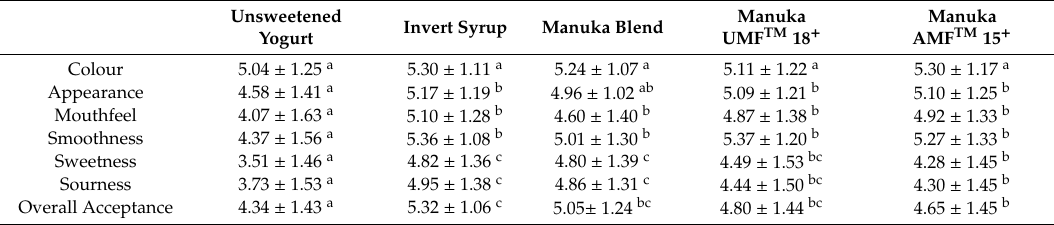
Manuka Manuka UMF TM 18 + AMF TM 15